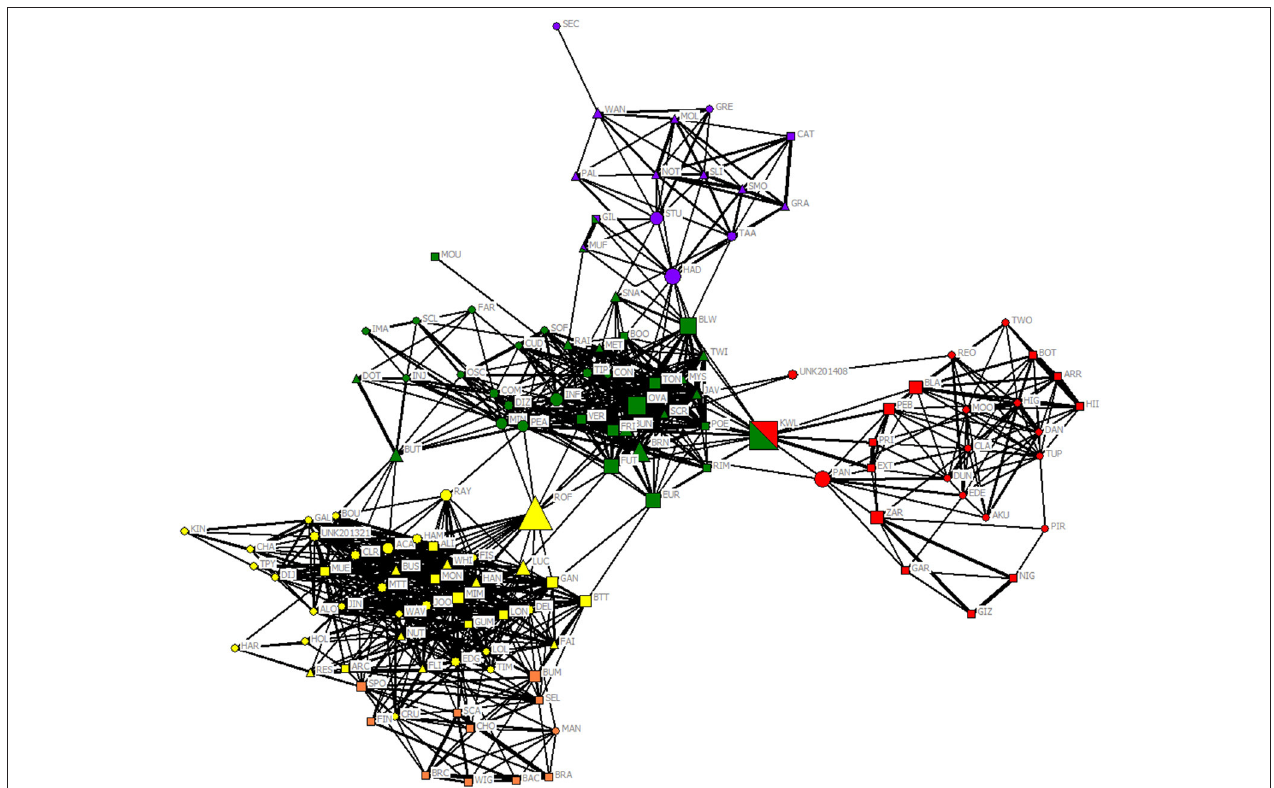
FIGURE 2 | Network diagram for 129 bottlenose dolphins using the HWI. The shape of each node indicates its sex (circle: females; square: males; triangle; unsexed), and the color of each node indicates its unit defined by the modularity of Newman (2006) (purple ComA; red ComB; green ComC; yellow and orange sub-communities D and D’), although three individuals were assigned to two different units depending on the method (Newman vs. Hierarchical linkage). Only links representing affiliations (HWI > 0.16) are shown, and link width is proportional to index weight. Node size is based on the betweenness centrality measure of each